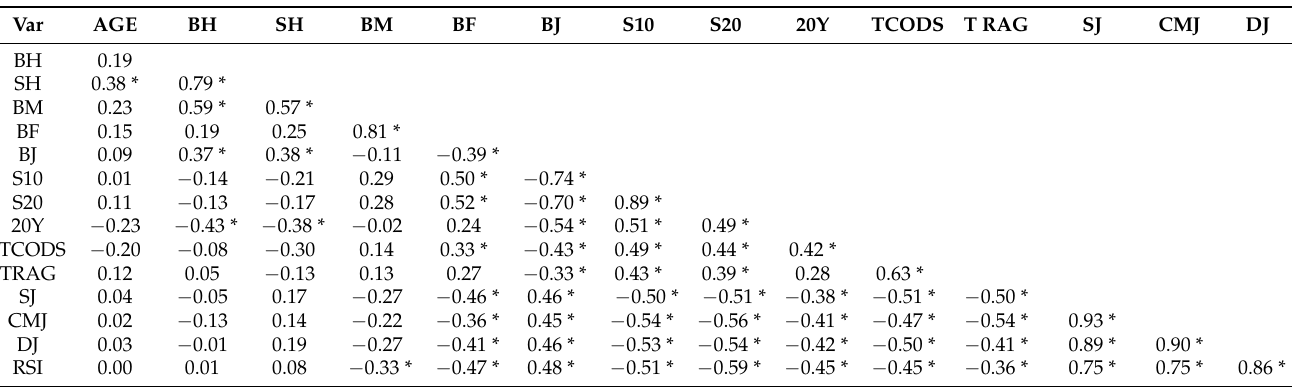
Table 2. Pearson’s moment correlation coefficients between the studied variables for girls.